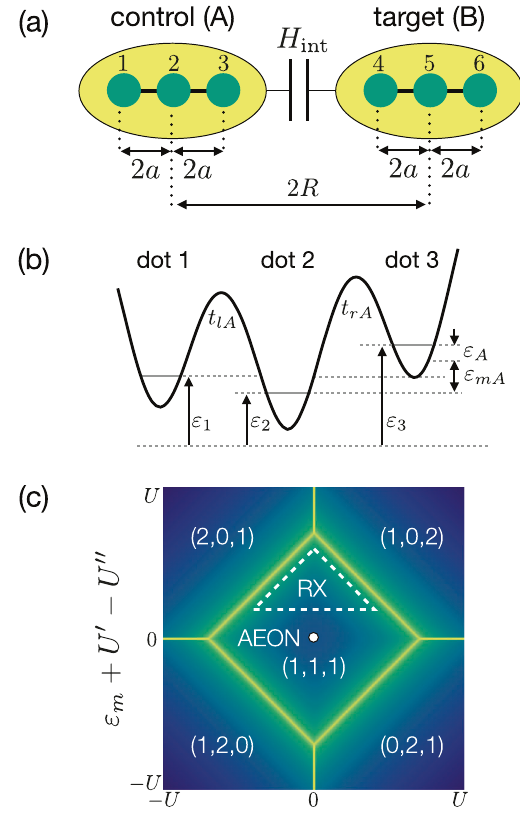
Fig. 1 Exchange-only (EO) qubit parameters. a Two EO qubits in a linear quantum dot (QD) array, with qubit A (B) in QDs 1 – 3 (4 – 6). We take a = 50 nm, R = 160 nm, with QD Bohr radius, a B = 25 nm in our calculations. Qubit A (B) is the control (target) qubit in the CPHASE and CNOT gates studied. The capacitive coupling between qubits is given by ^ H int (Eq. (6)). b Schematic of parameters in qubit A. Left/ right tunnel couplings are given by t lA/rA . Detuning parameters ε i control the relative single-particle energies between QDs, repre- sented by arrows from a reference energy to the ground orbital energy of each QD. Outer and middle detunings, ε A (cid:1) ε 1 (cid:3) ε 3 ð Þ = 2 , with the tunnel couplings are suf fi cient to describe single-qubit dynamics. For all our results, we take a re fl ection symmetry in the parameters of the two qubits: ε B = − ε A , = ε = t = t ε mB mA , t lB rA , and t rB lA . c Detuning space of an EO qubit and charge occupation numbers. The AEON single-qubit double ( ε and ε m ) sweet spot is at the center of the (1,1,1) region at ð ε ; ε m Þ ¼ ð 0 ; U 00 (cid:3) U 0 Þ (white circle). The RX single-qubit working region is indicated by the dashed triangle. In our study, the RX working point is taken to be at ð ε ; ε m Þ ¼ ð 0 ; U 0 Þ (i.e., at its single-qubit ε sweet spot for equal tunnel